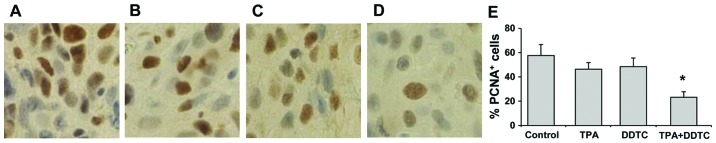
Effect of treatment 12-O-tetradecanoylphorbol-13-acetate (TPA) or diethyldithiocarbamate (DDTC) alone or in combination on the expression of proliferating cell nuclear antigen (PCNA) in PANC-1 tumors. Immunohistochemistry with a PCNA antibody was performed on the paraffin-embedded sections of PANC-1 tumors collected from the mice following treatment as described in Fig. 5. Representative micrographs of PCNA immunostaining in tumors from the (A) control, (B) TPA-treated, (C) DDTC-treated and (D) TPA + DDTC-treated groups are shown. PCNA positive cells were determined using a microscope (Nikon Optiphot) and (E) expressed as a percentage of PCNA-positive cells. Each value represents the mean ± SE. *P<0.01, compared to treatment with either agent alone.